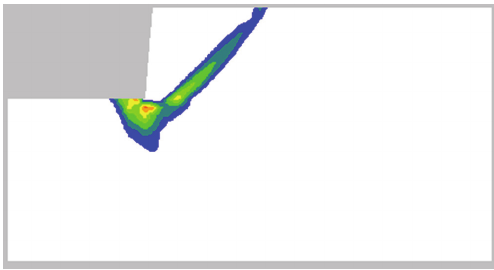
Figure 6: Calculation model of active earth pressure (unit: m).